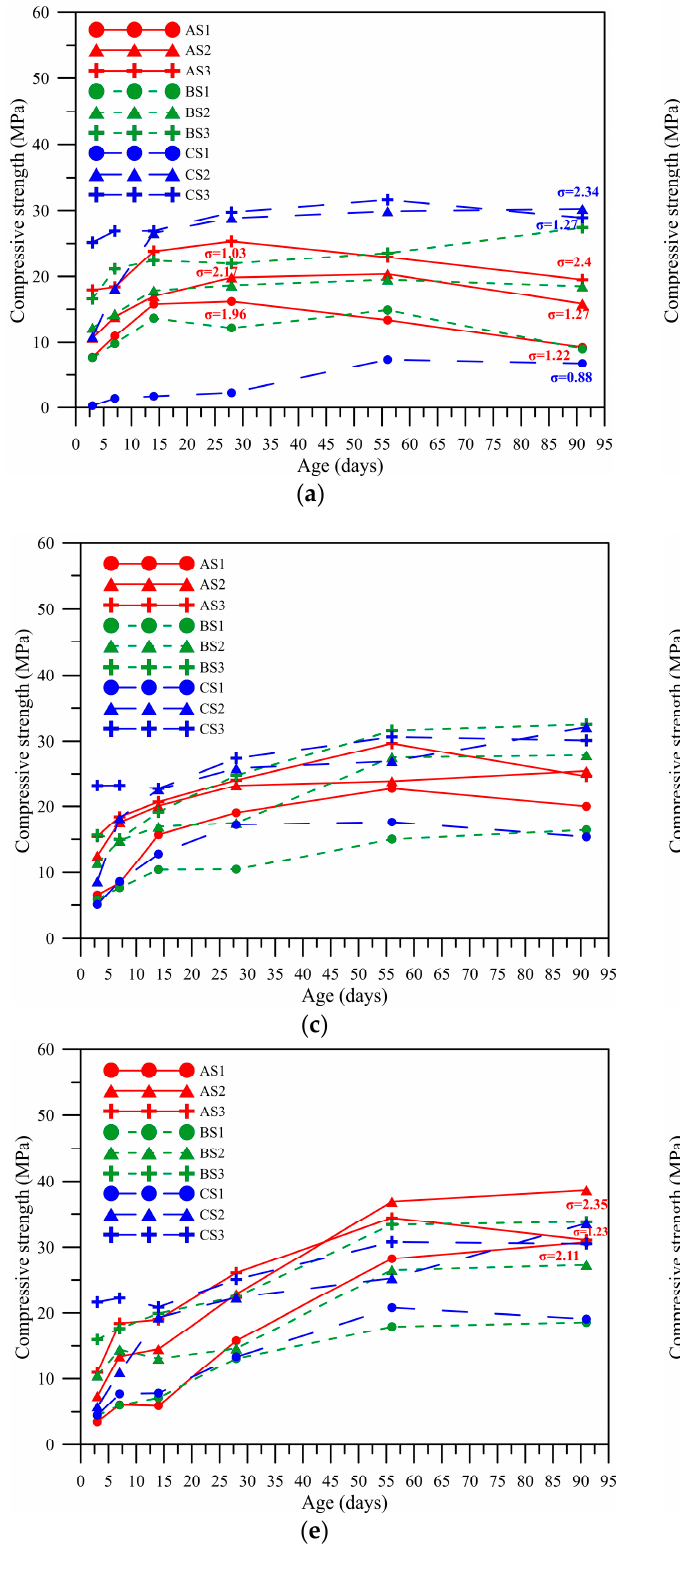
Figure 5. Compressive strength at different alkali equivalents for each proportion at different ages. ( a ) AE% = 3%, ( b ) AE% = 4%, ( c ) AE% = 5%, ( d ) AE% = 6%, ( e ) AE% = 7%, ( f ) AE% = 8%.